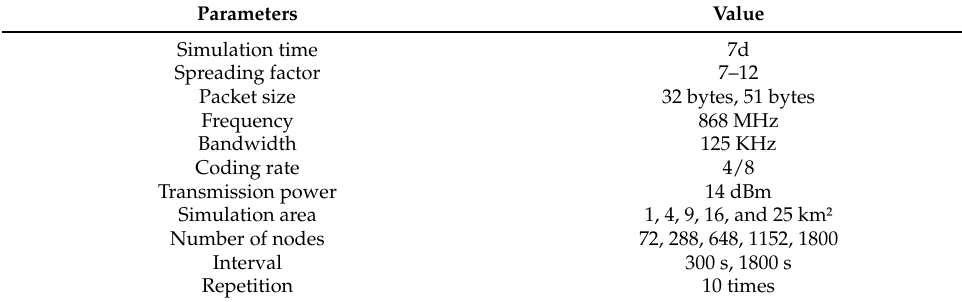
Figure 4. Water monitoring and leakage detection flowchart. Table 2. The main simulation